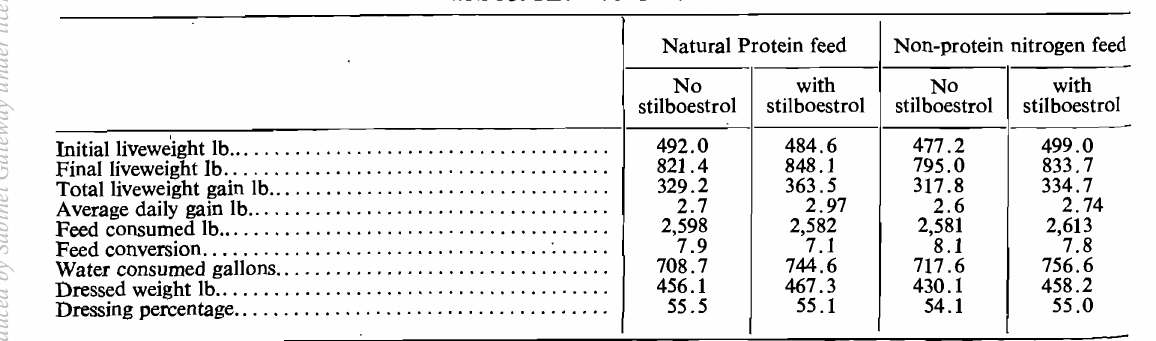
TABLE H.-DETAILS OF MEAN LIVEWEIGHT GAINS, FEED AND WATER CONSUMPTION, FEED CONVERSION, DRESSED WEIGHTS AND DRESSING PERCENTAGE OF CATILE FED FOR 122 DAYS ON NATURAL PROTEIN AND NON-PROTEIN NITROGEN DIETS WITH